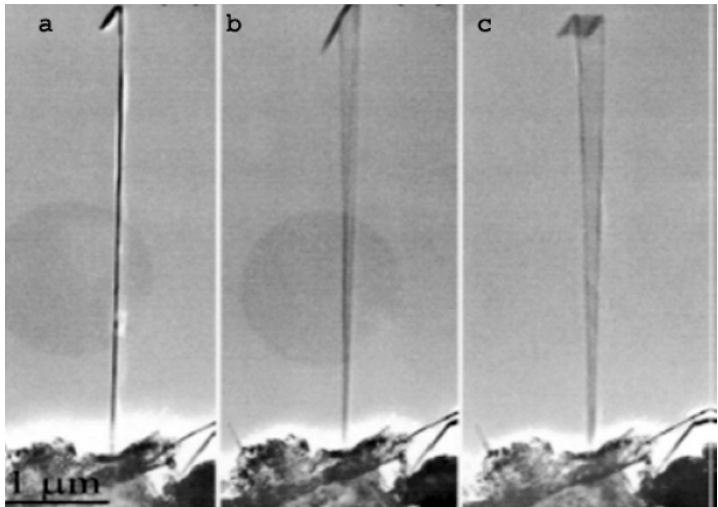
Fig. 3. A selected ZnO nanobelt with a hooked end at (a) stationary, (b) resonance at 731 kHz in the plane almost parallel to the viewing direction, and (c) resonance at 474 kHz in the plane closely perpendicular to the viewing direction, reprinted with permission from Ref [47], Copyright 2003 American Institute of